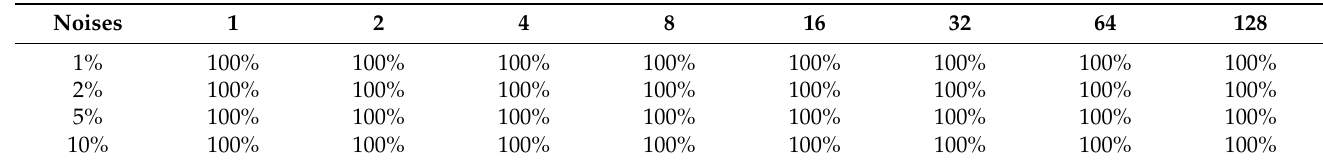
Table 2. Detection results of the AVS within the background with separated